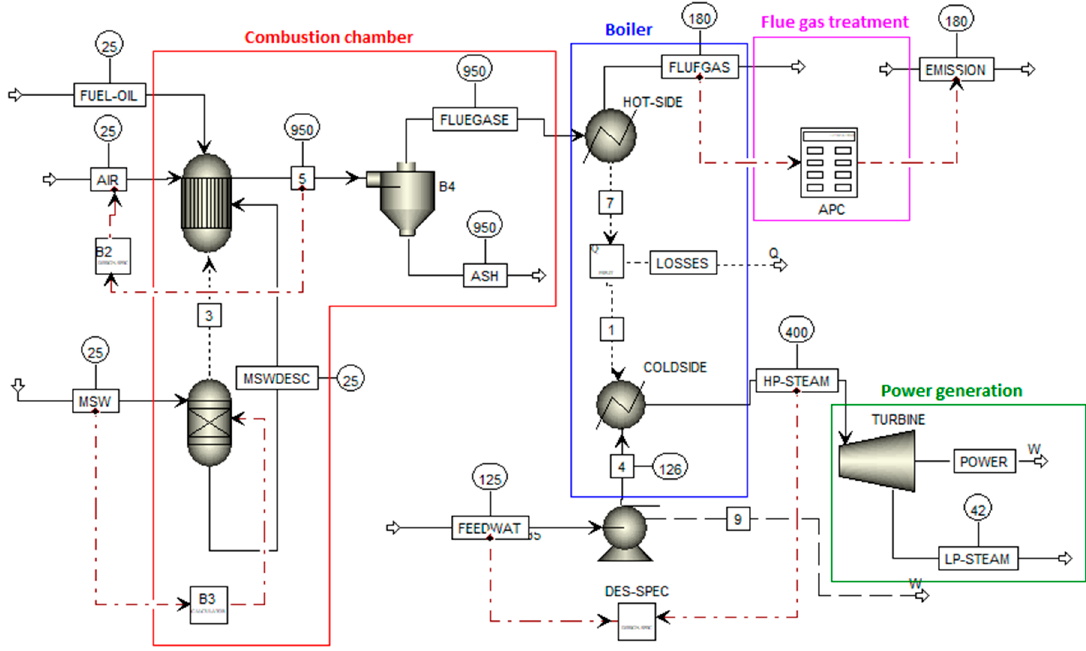
Figure 7. Flowsheet of the Aspen Plus model for the prefeasibility study of WTE plant in the City of Havana.